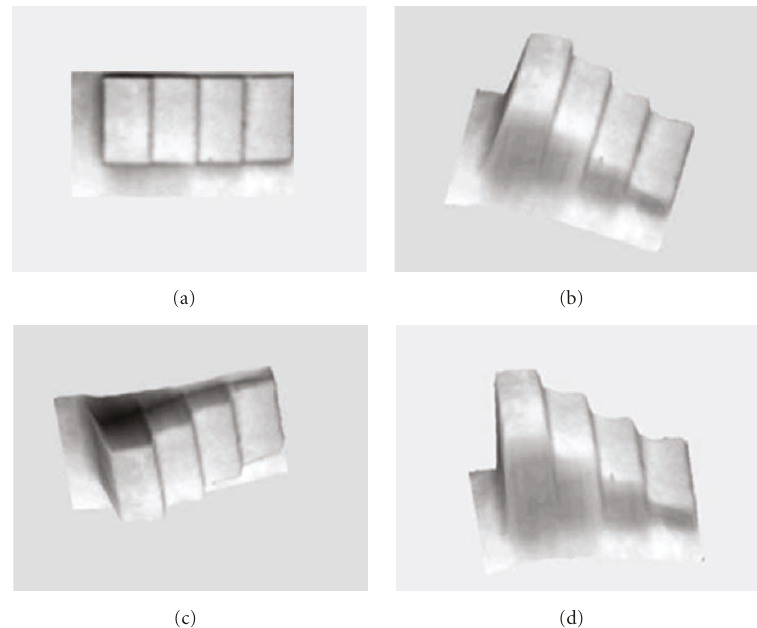
Figure 5: Underwater 3D images of dark-gray-painted, sanded, metallic ladder immersed in clean water (tap water) at a distance of 1.5 m from receiver obtained by AMULOR system working at f m = 36 . 7MHz. Note that the ladder is shown with various orientations.